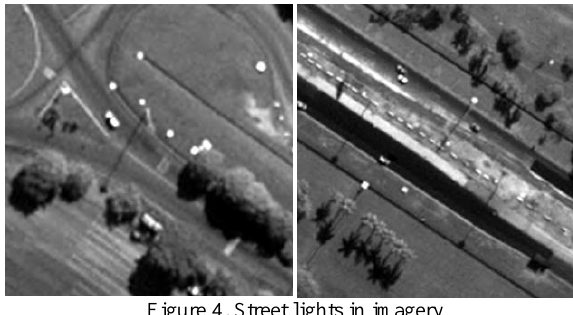
Figure 4. Street lights in imagery